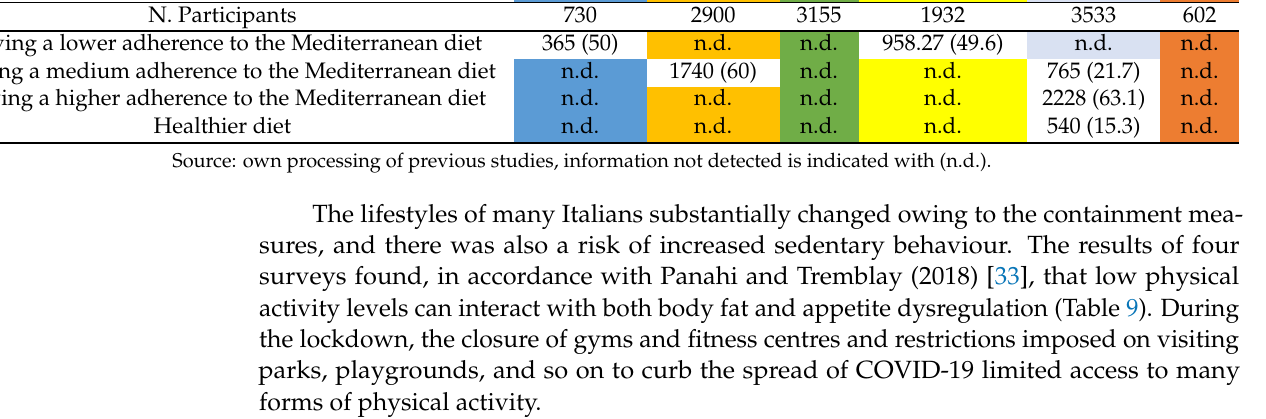
Table 8. Adherence to the Mediterranean diet, absolute value (N.) and (%) on the total. Survey